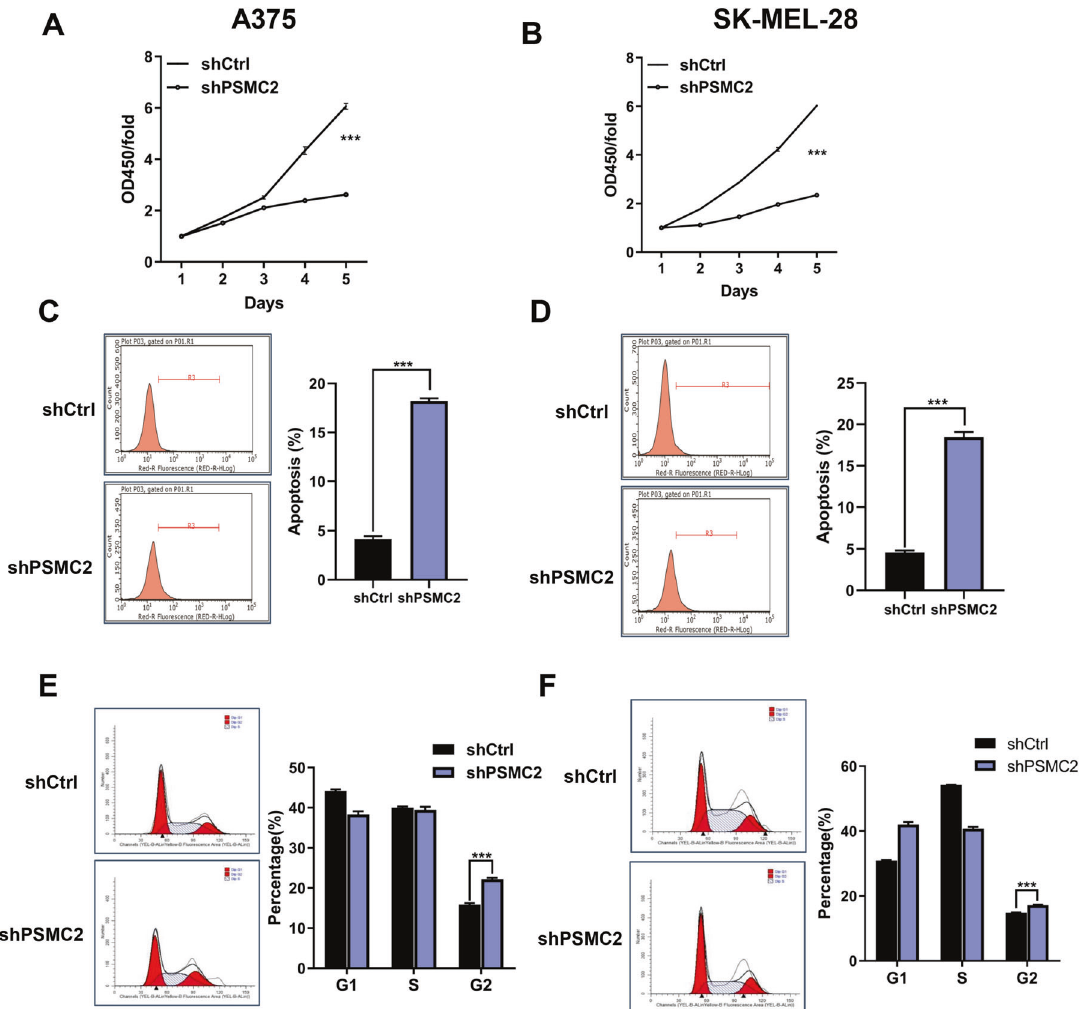
determined by fl ow cytometry assays in A375 and SK-MEL-28 cells with shPSMC2 transfection and control cells. The apoptotic rate was calculated as the percentage of Annexin APC positive cells. E , F Cell cycle was determined in A375 and SK-MEL-28 cells by fl ow cytometry fi ve days after treatment with shPSMC2. The diagrams quanti fi ed cell fractions in the G1, S, and G2/M fractions were shown. Each independent experiment was repeated at least three times. Data were expressed as the mean ± SD. *** p <